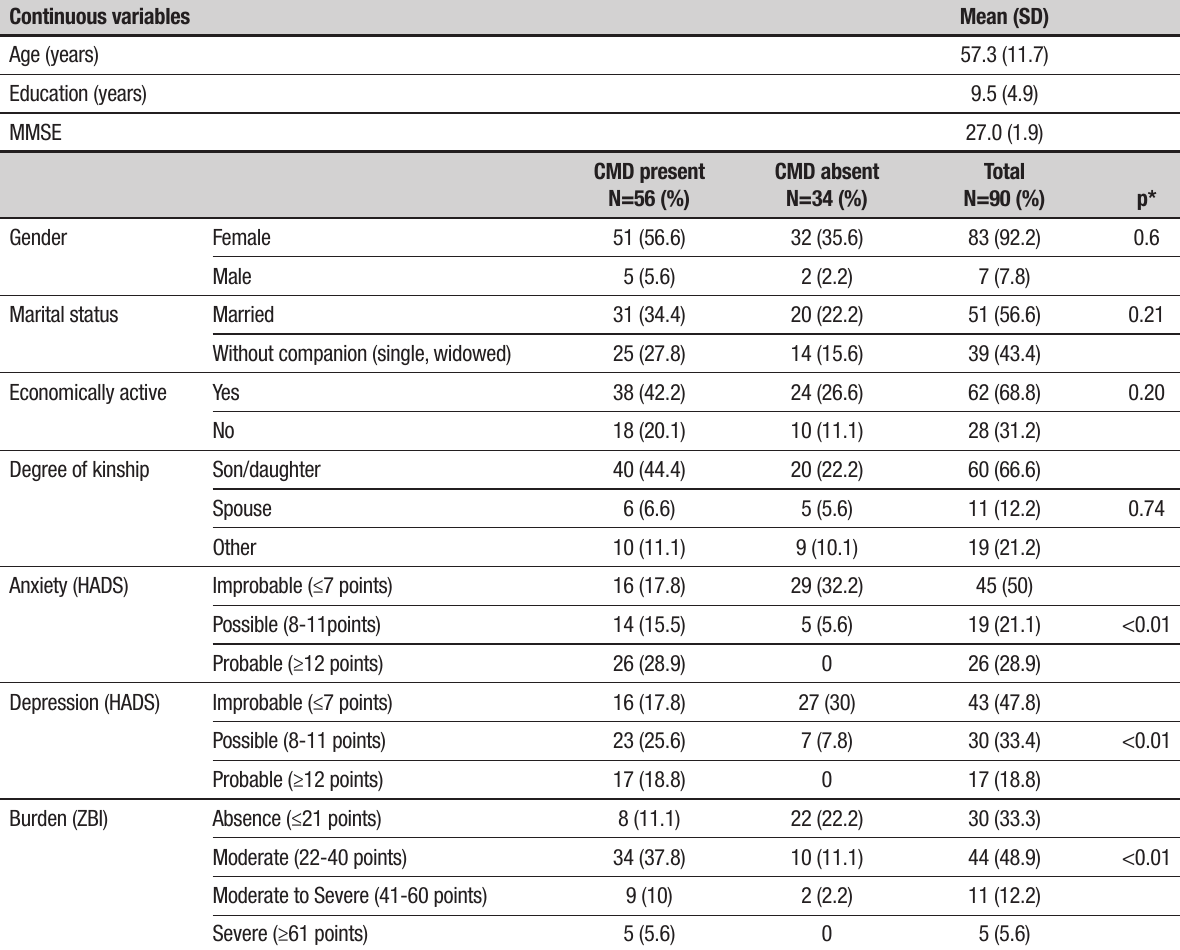
Table 1. Distribution of sociodemographic and mental health variables according to presence/absence of common mental disorder (CMD) in dementia patient carers, with group